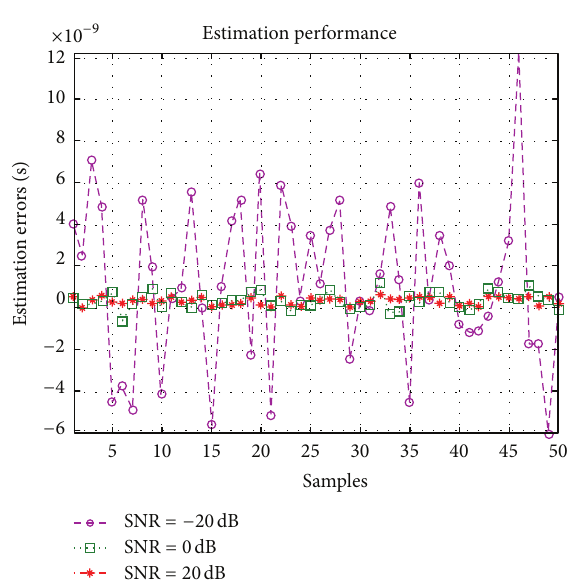
Figure 7: Statistical performance of the baseline estimation